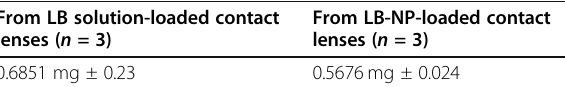
Table 4 Drug uptake by contact lenses after 24 h of soaking period From LB solution-loaded contact lenses ( n = 3) 0.6851 mg ± 0.23